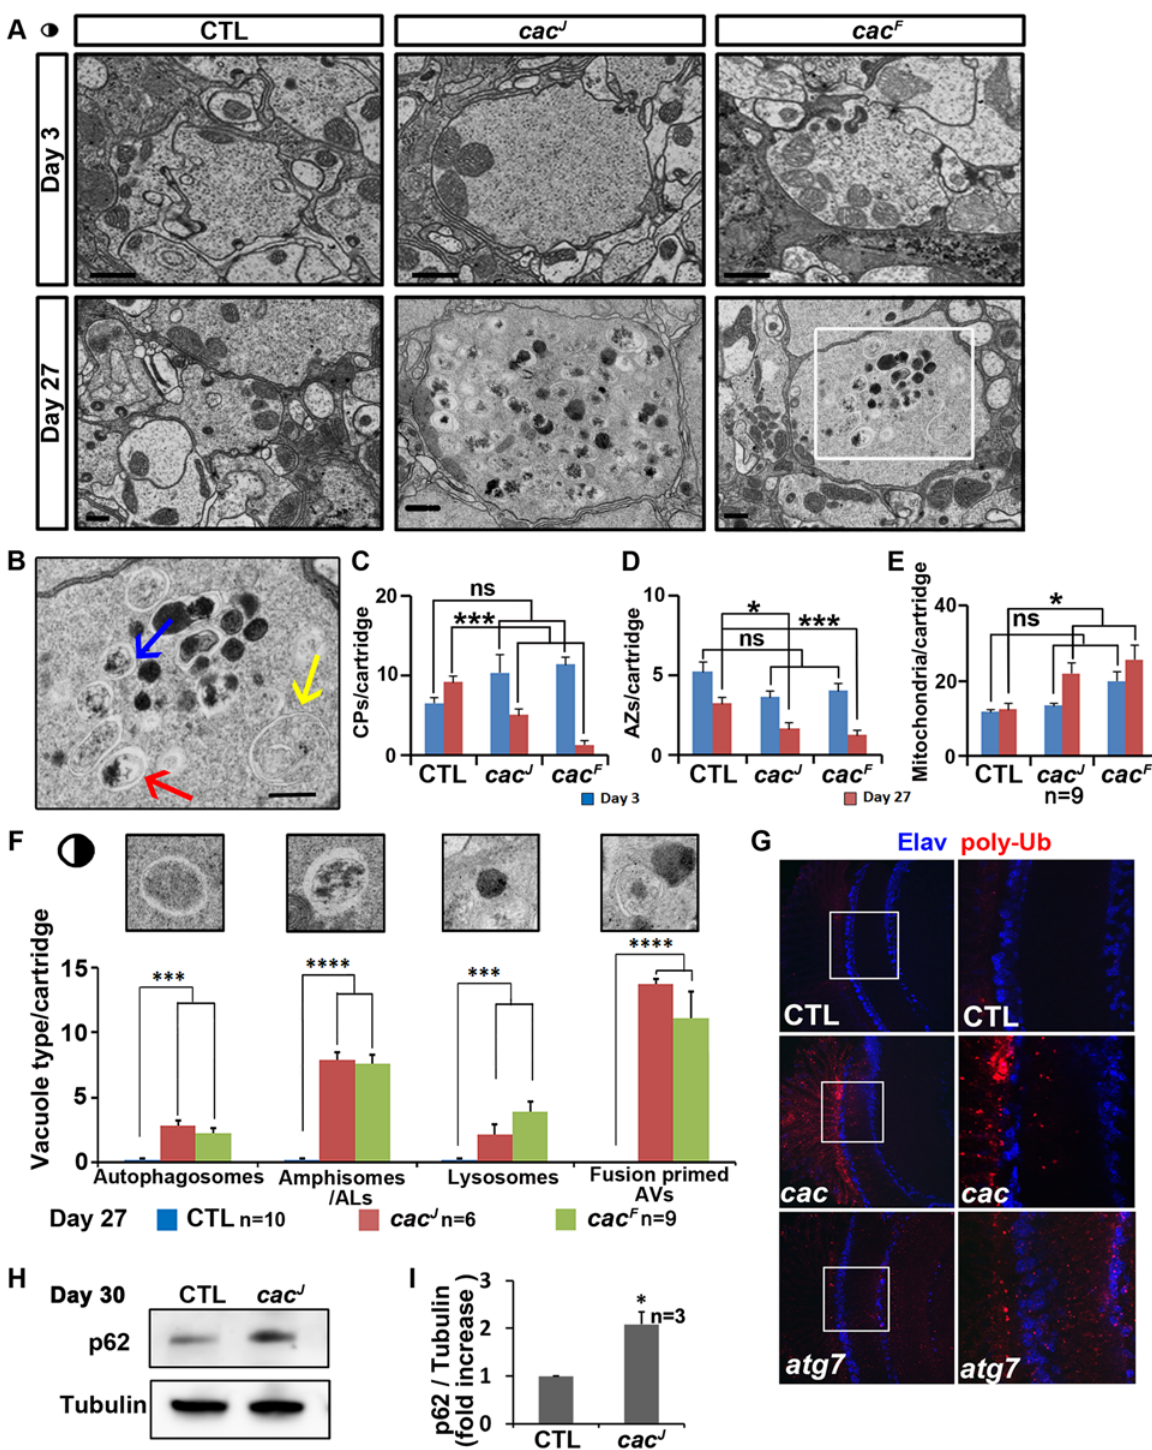
Fig 2. Aged cac mutant photoreceptor terminals show morphological defects and accumulate late stage AVs. A. TEM sections of 3- and 27-days-old photoreceptor terminals of flies. Terminals of 27-days-old flies show terminal expansion, loss of capitate projections (CPs) and active zones (AZs) and increased number of mitochondria per terminal. Scale bars, 500 nm. B. Inset from A representing the photoreceptor terminal boxed in white. Yellow arrow indicates double-membraned autophagosome, red indicates amphisome, and blue indicates two fusion-primed AVs. Scale bars, 500 nm. C-E. Quantification of CPs, AZs, and mitochondria per cartridge, respectively. Data are presented as means ± SEM. F. Quantification of the different AVs per cartridge. The